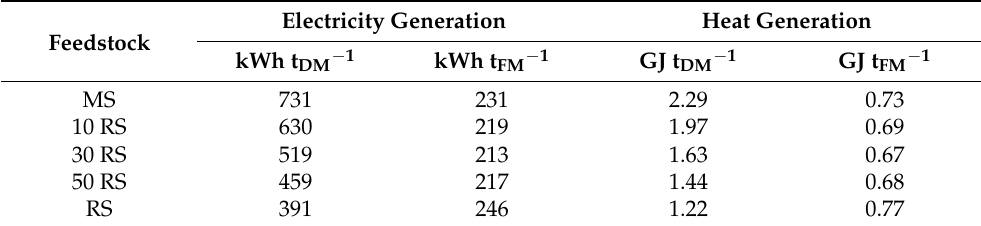
Figure 4. The concentration of ( a ) hydrogen sulfide (H 2 S) and ( b ) ammonia (NH 3 ) in biogas produced from mono- and co-digestion of maize and reed silages. MS—maize silage, 10 RS—maize silage with 10% content of reed silage, 30 RS—maize silage with 30% content of reed silage, 50 RS—maize silage with 50% content of reed silage, and RS—reed silage. Standard errors are shown as vertical bars (where absent, bars fall within symbols). Table 3. Electricity and heat generation from biogas produced by mono- and co-digestion of maize and reed